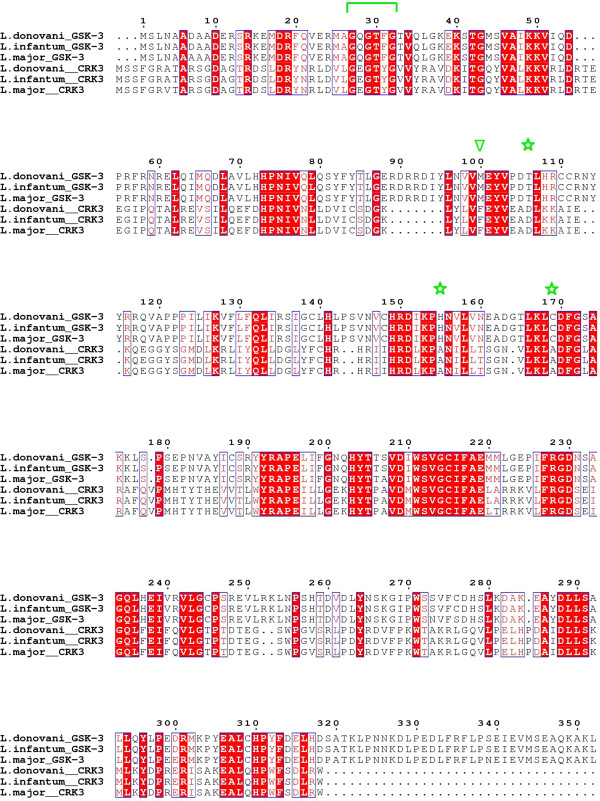
Multiple sequence alignment of GSK-3 and CRK3 from three relatedLeishmaniaspecies. The multiple sequence alignment depicts the high homology between GSK-3 and CRK3 of three Leishmania species, namely L. donovani, L. infantum and L. major (Uniprot codes: A6N857, A4HXQ3, Q4QE15 for GSK-3 and Q4K8Z1, A4ICT0, Q96526 for CRK3, respectively). The gatekeeper positions as well as the three non-conserved residues of the ribose sub-site are highlighted by green stars and the glycine-rich loop is marked by a green bracket. Alignment was performed using ClustalW with default settings and the depiction was prepared using ESPript software (http://espript.ibcp.fr) [37,38].